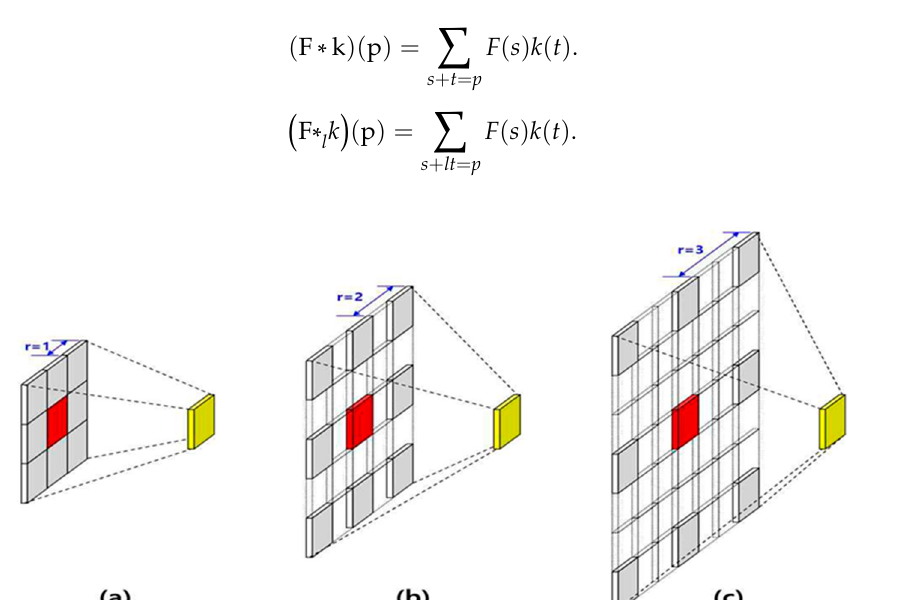
Figure 5. ( a ) Atrous convolution when r = 1, ( b ) Atrous convolution when r = 2, ( c ) Atrous convolution when r = 3.